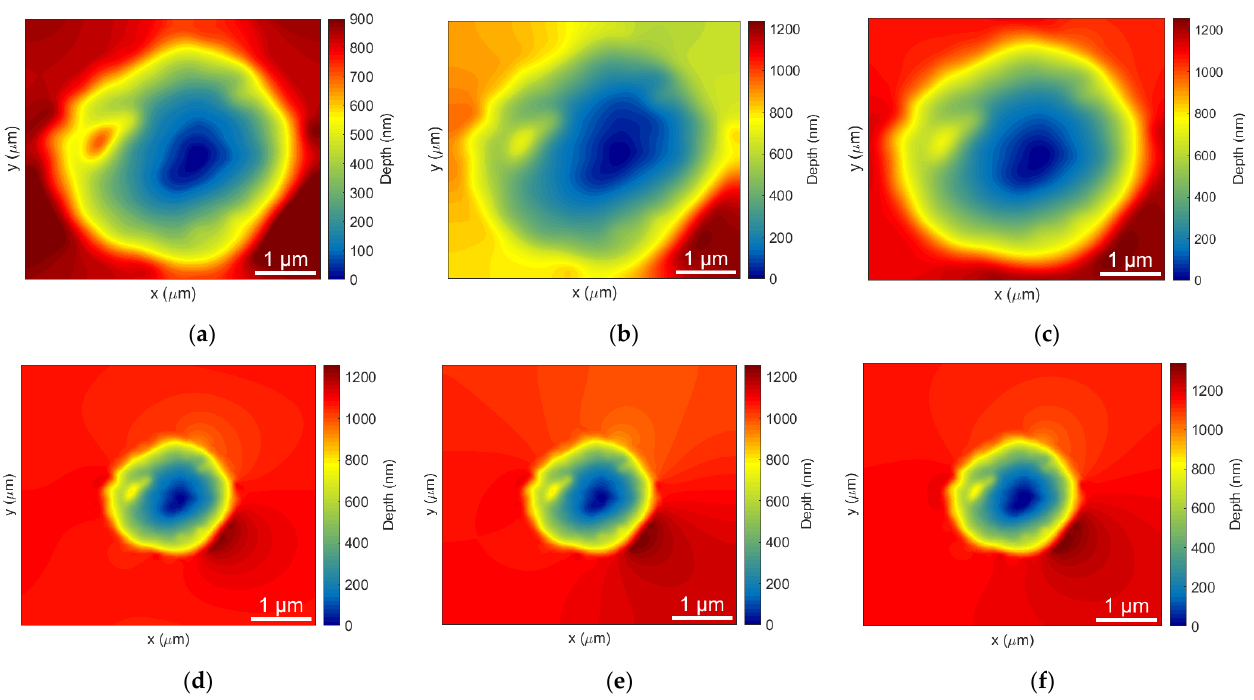
Figure 5. 2D crater images retrieved using TIE from digitally processed SEM-images: ( a , d ) no boundary conditions; ( b , e ) Neumann boundary conditions; ( c , f ) Dirichlet boundary conditions.